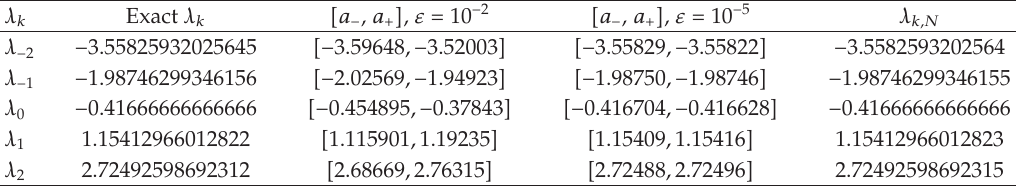
Table 2: The approximation λ k,N and the exact solution λ k are all inside the interval (cid:3) a − , a (cid:9) (cid:4) for di ff erent values of ε .